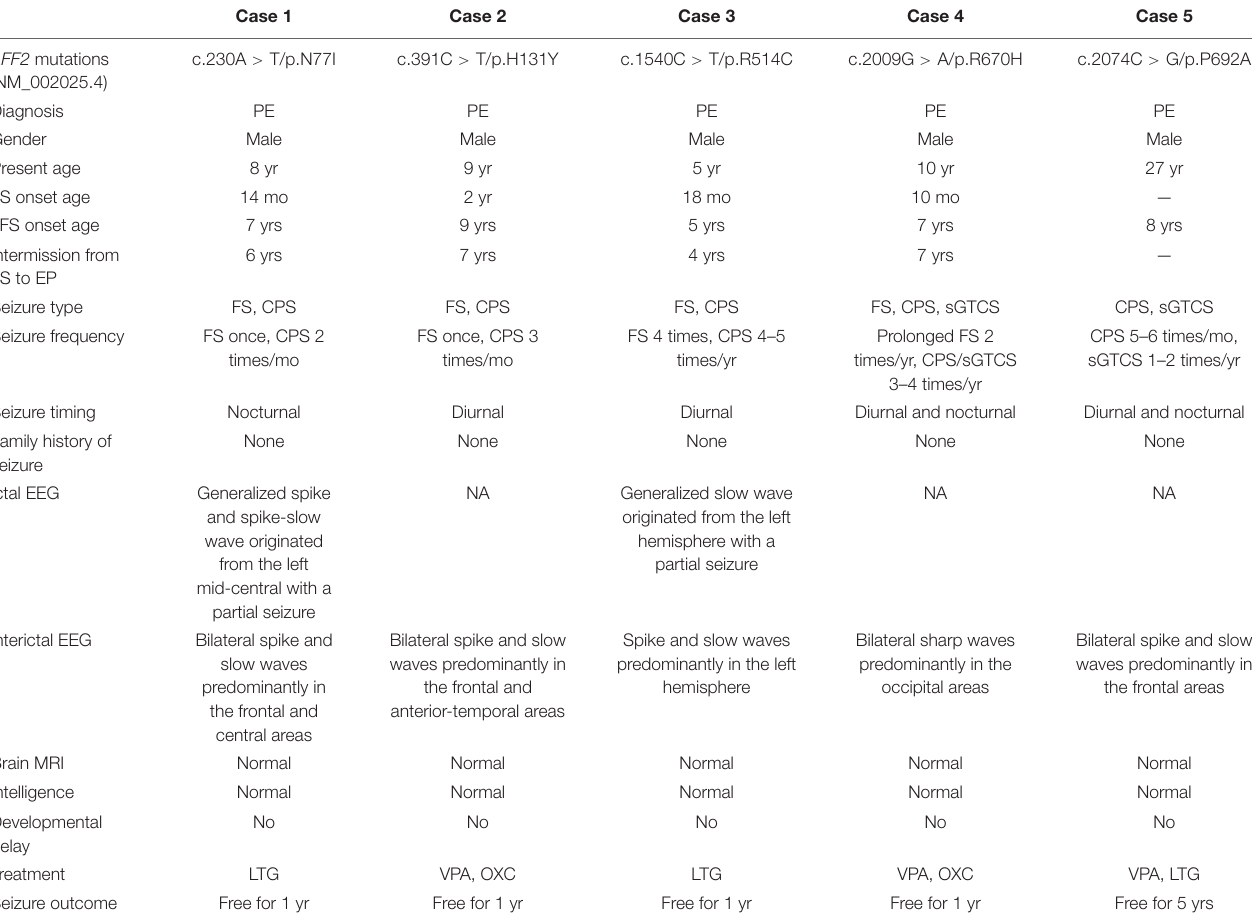
TABLE 1 | Clinical features of the cases with AFF2 mutations.